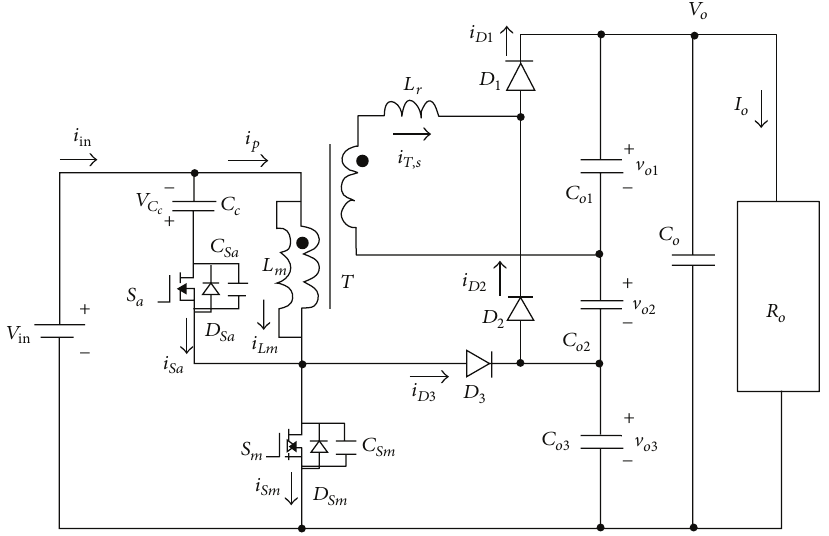
Figure 9: New zero-voltage switching DC-DC converter, Lin and Dong